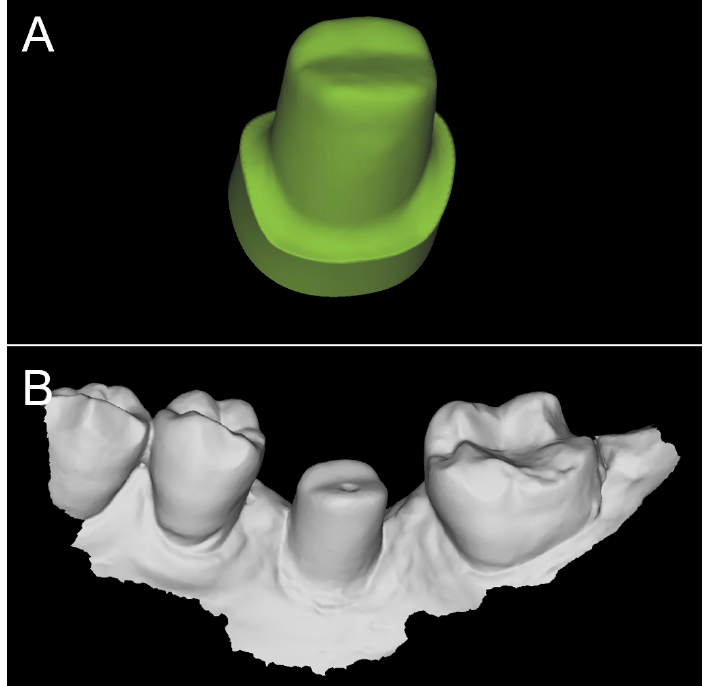
Figure 8. The original CAD drawing is imported in the CAD software for the superimposition. ( A ) the original CAD drawing of the individual abutment with clear and visible margin lines; ( B ) the corresponding mesh captured in the mouth, in which the margin line is not visible because subgingival.